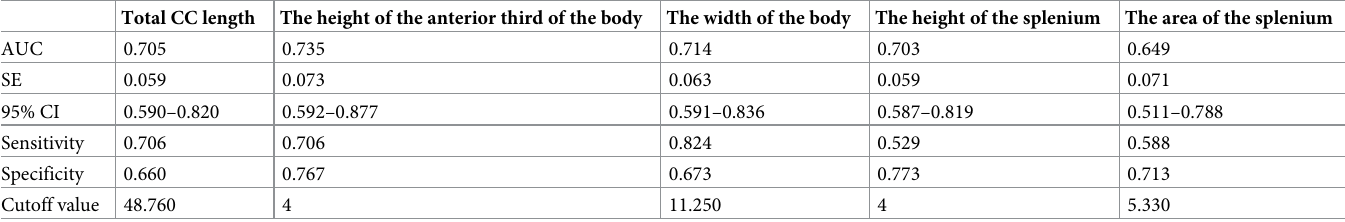
Table 4. Receiver operating curve analysis of corpus callosum measurements for distinguishing dementia from other groups. Total CC length The height of the anterior third of the body The width of the body The height of the splenium The area of the